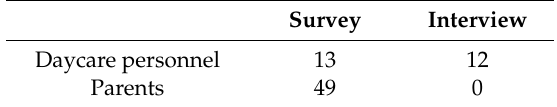
Table 2. Number of the survey respondents and interviewees in the